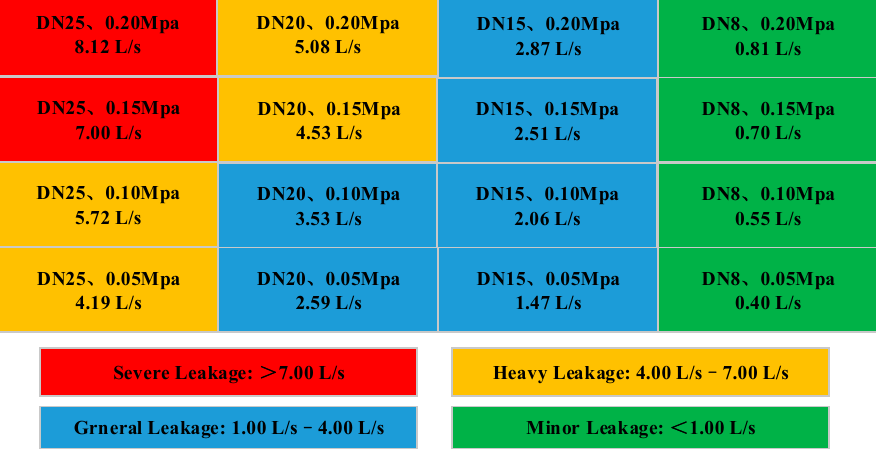
Figure 18. Leakage level groups.